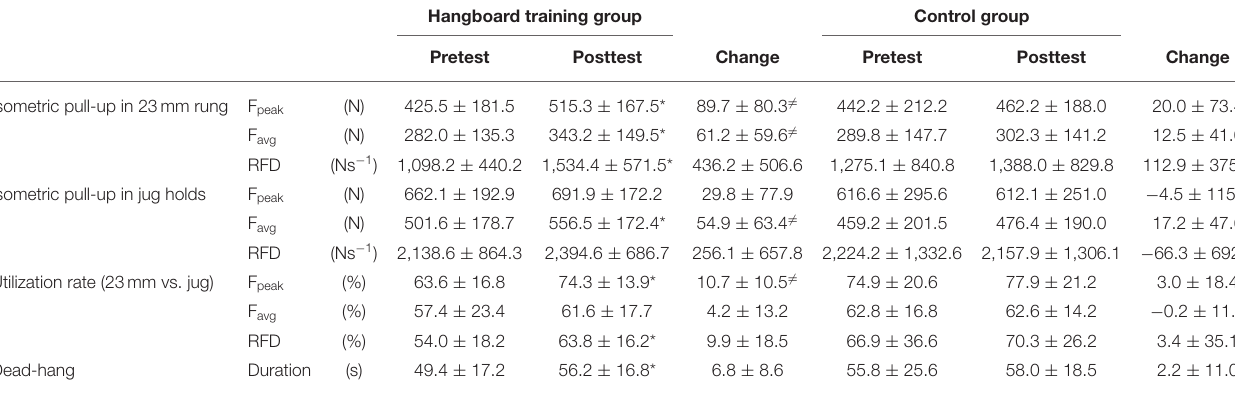
TABLE 3 | Absolute data (pre and post) and absolute difference between pre and post for all